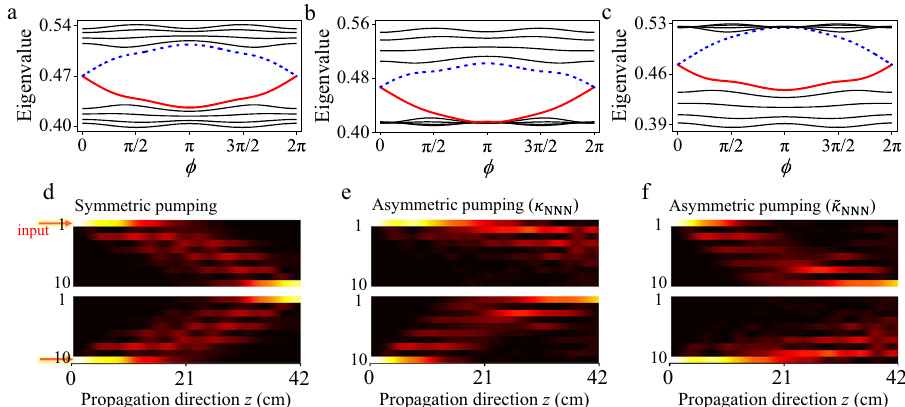
Fig. 2 Energy spectrum and beam propagation for topological pumping. The energy spectrum for a conventional Rice-Mele model without next-nearest- neighbor (NNN) hopping, and b , c extended Rice-Mele model with positive ( κ NNN = 0.007 mm − 1 ) and negative ( ~ κ NNN ¼ (cid:3) 0 : 007 mm (cid:3) 1 ) NNN hopping terms, respectively. Two symmetric pump channels are shown in a but only one of the channels ( b , c ) remains when adding the NNN hopping. Correspondingly, the beam propagation on these photonic lattices demonstrate two symmetric pumping in d and asymmetric pumping in e , f . The beam propagation in the blocked channels [the upper panel in e , and the lower panel in f ] show the topological edge state con fi nement along the array boundaries. The simulation parameters are taken from the